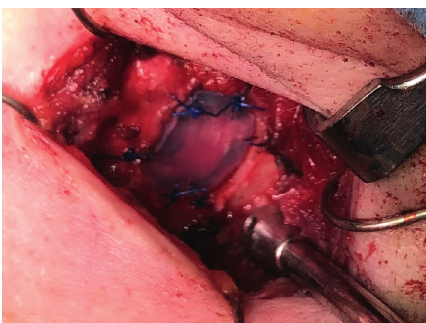
Figure 5: A silastic block trimmed to fit into the thyroid cartilage defect and sutured in place using a series of interrupted 4-0 prolene